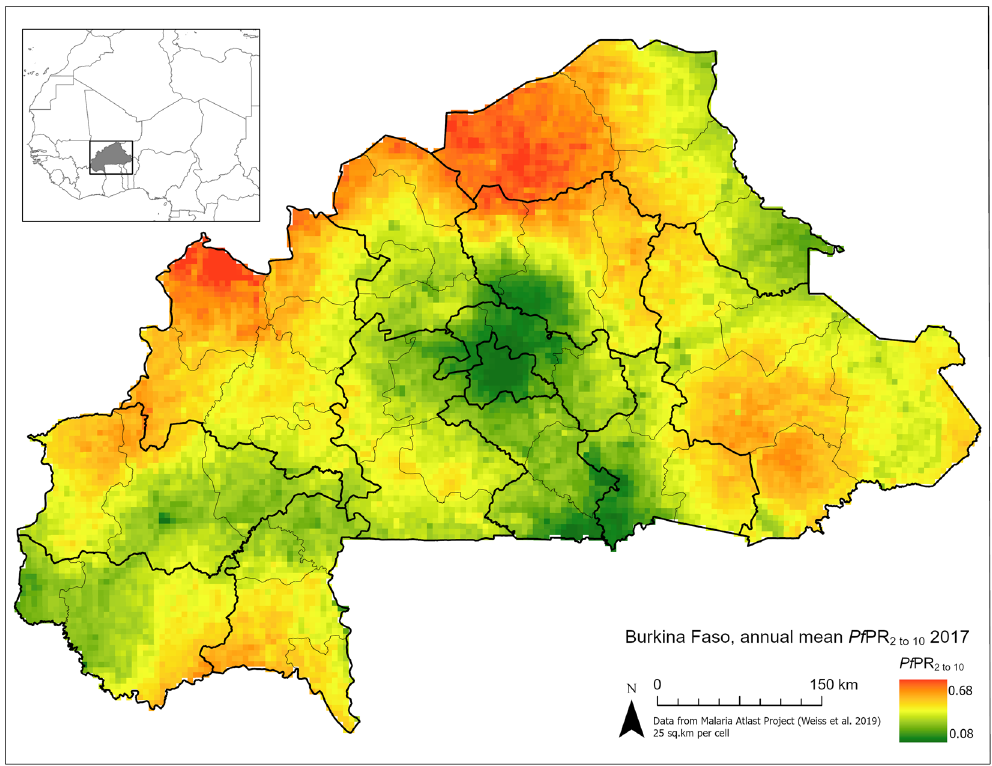
Figure 1. Prevalence of P. falciparum malaria in Burkina Faso based the Malaria Atlas Project projections for 2017 10 . Map prepared by the authors using ArcGIS Pro (version 2.9.3, https:// www. esri. com/ en- us/ arcgis) using administrative boundaries from the World Bank Group 11,12 , and prevalence data from the Malaria Atlas Project 10